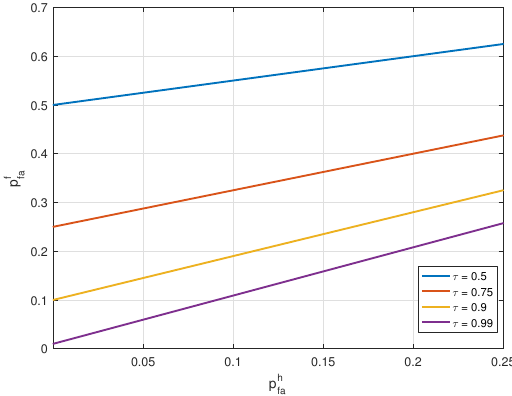
Figure 9. Variation of p f